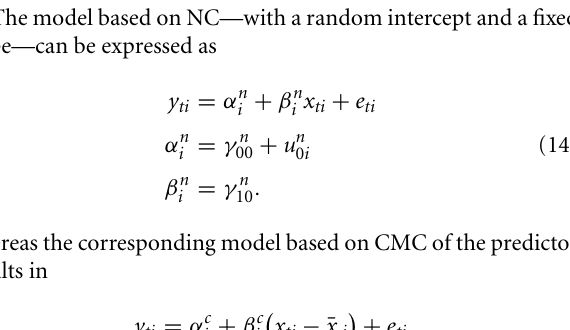
FIGURE 1 | Illustration of within-person and between-person relationships between two variables. Each ellipse represents the data from a single person. Dashed lines represent the between-person slope (i.e., β B ),